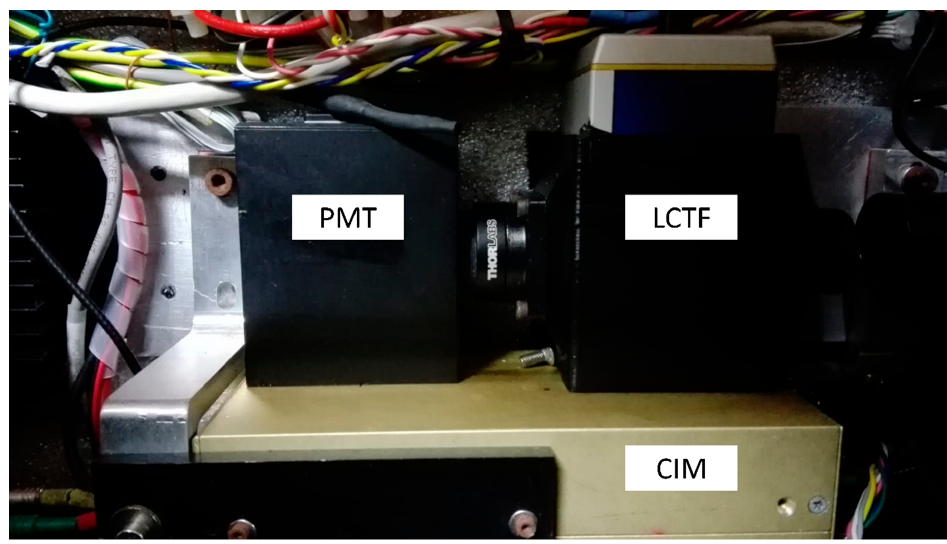
Figure A2. Photo of the CIM unit with the LCTF apparatus mounted on his top.